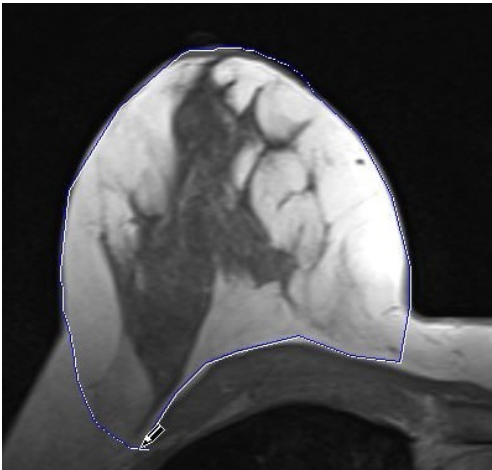
Figure 4. Preoperative volumetry of the whole breast T2 - weighted image. The measurements were made using the image processing software Syngo.via (Siemens Healthcare GmbH, Erlangen, Germany).